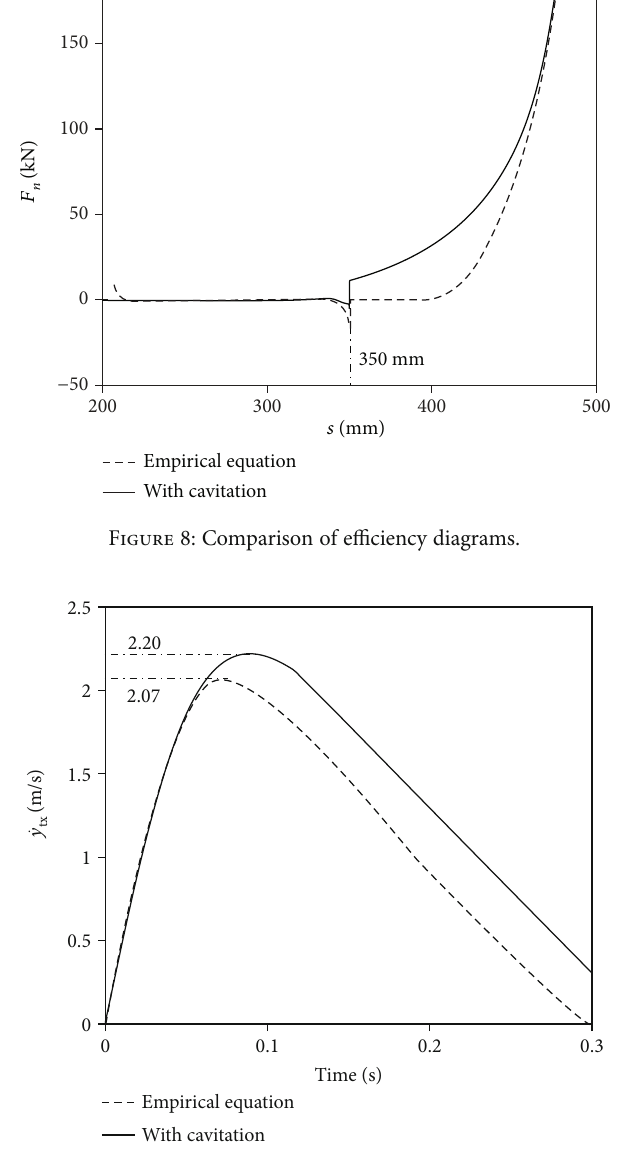
Figure 9: Comparison of vertical velocity of spring support mass.